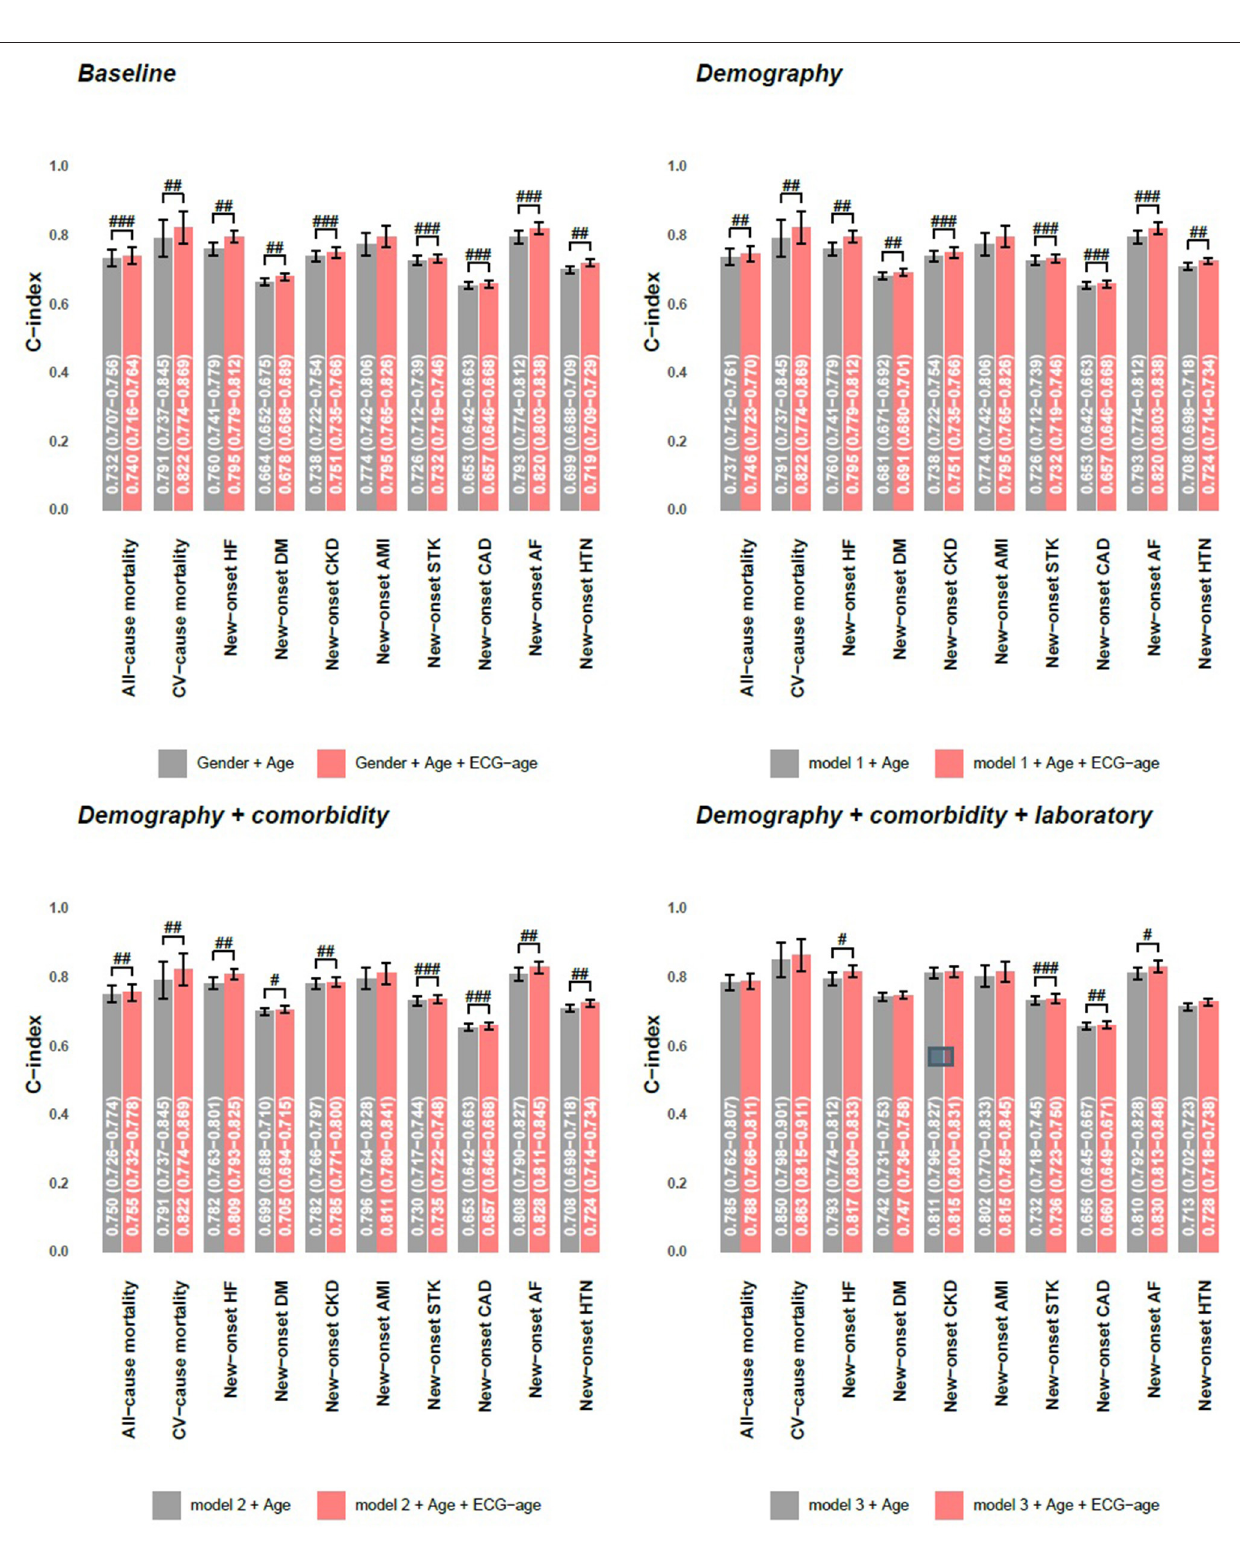
Frontiers in Cardiovascular Medicine |